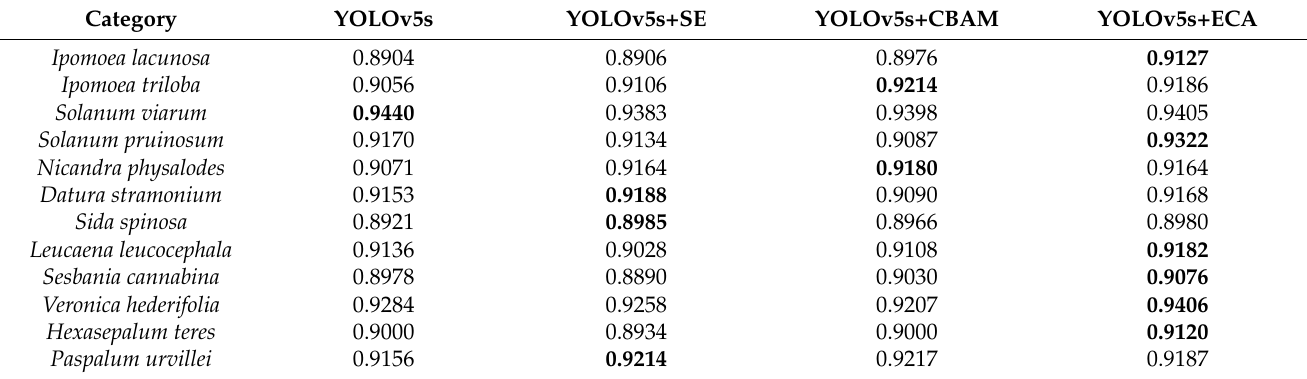
Table 6. Comparison of F1-score detection results for 12 invasive plant seeds based on four algorithms with the produced data sets. Bold data represent the best